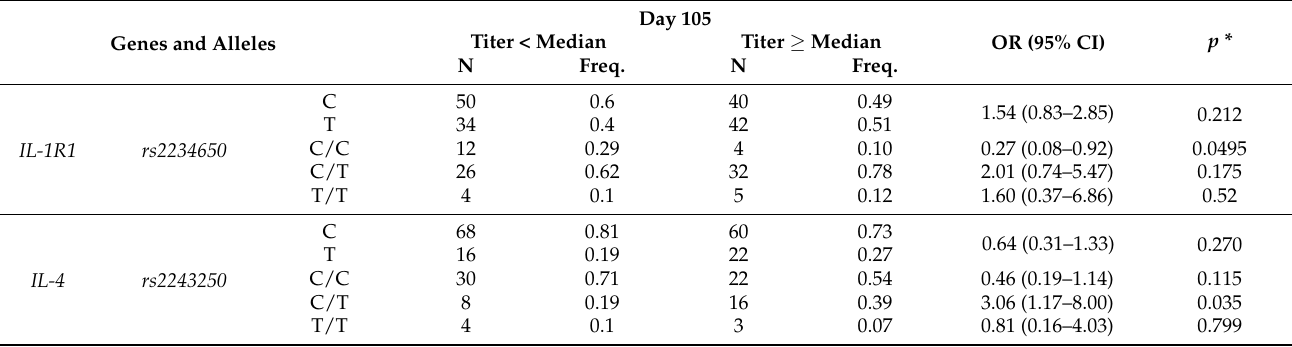
Table 7. Significant associations of genotypes of IL-1R1 rs2234650 and IL-4 rs2243250 with anti-SARS- CoV-2 S1/S2 antibody titers measured after 105 days from the administration of the second dose of recombinant mRNA vaccine (83 uninfected subjects).